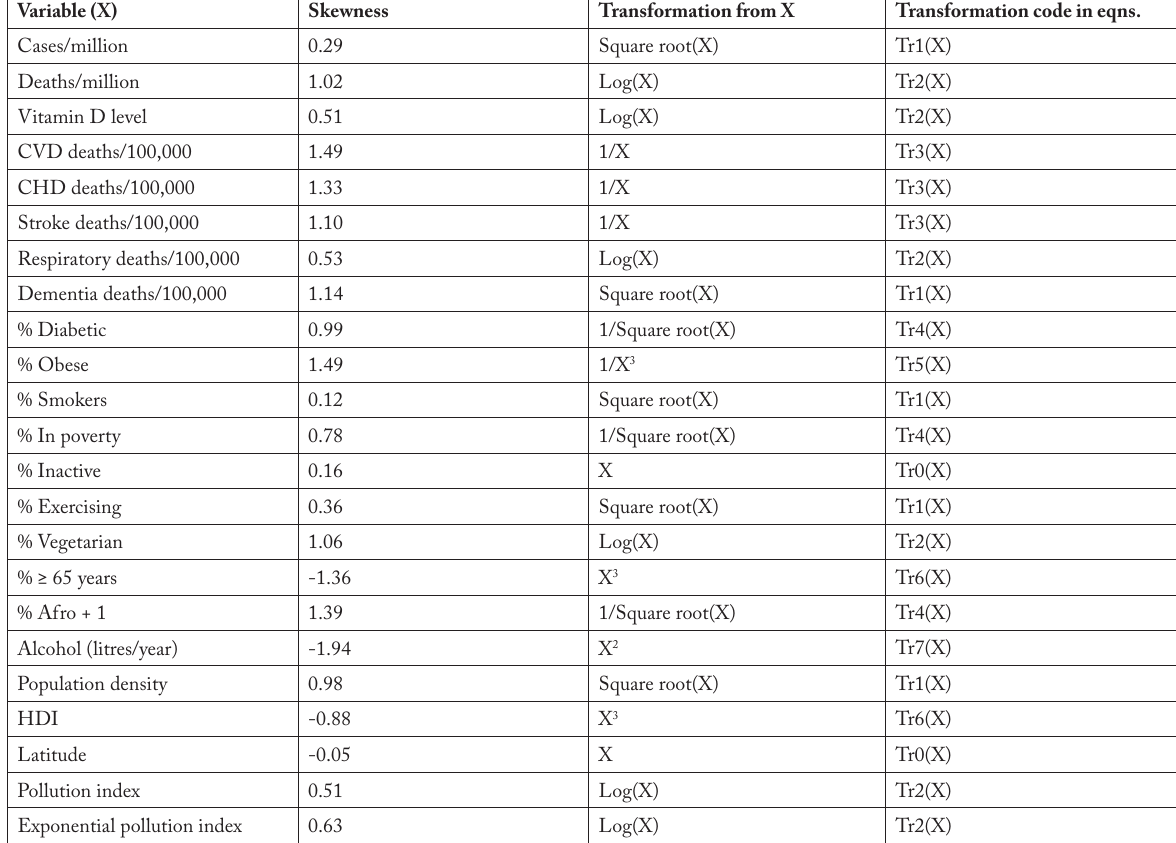
Table 2. Transformation of cases, deaths and predictor variables using Box and Cox